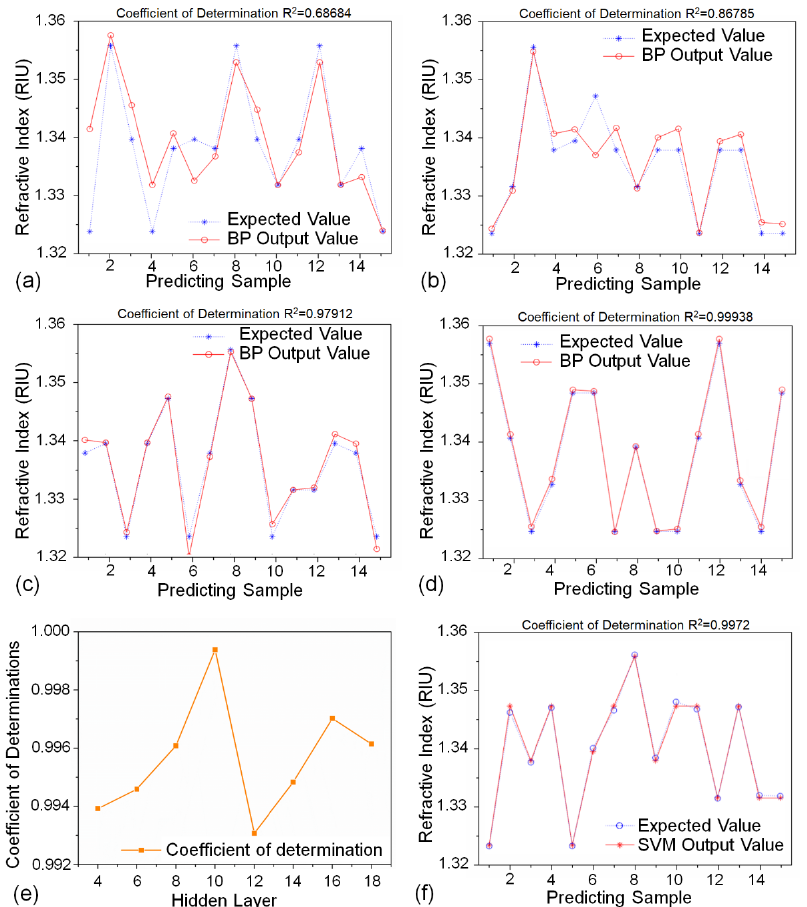
Figure 4. ( a ) BP neural network result by using the grayscale mean of VIS images as input; ( b ) BP neural network result after adding the grayscale mean of NIR images as input; ( c ) BP neural network result by using the grayscale means of VIS and NIR images and RGB summation of the VIS edge detection images as input; ( d ) BP neural network result after adding RGB summation of the NIR edge detection images as input. ( e ) Coefficient of determination when the number of neurons in hidden layers is 4, 8, 10, 12, and 14; ( f ) SVM result by using the grayscale means of VIS and NIR images and RGB summation of the VIS edge detection images as